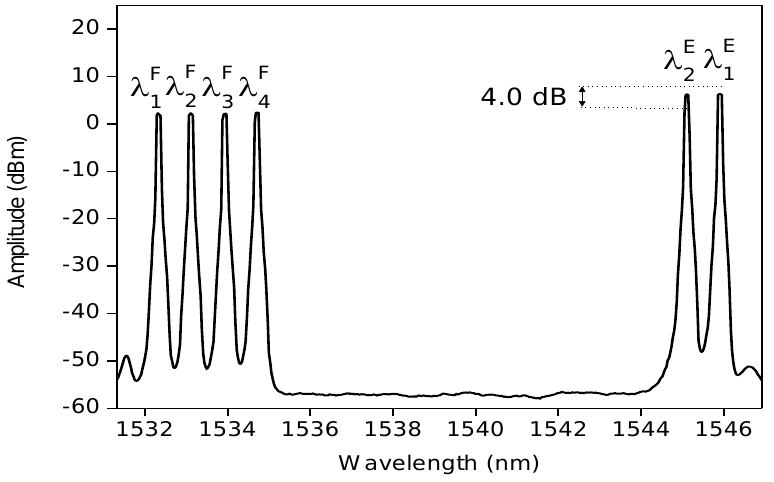
Figure 2. Wavelength spectrum measured at the output of the